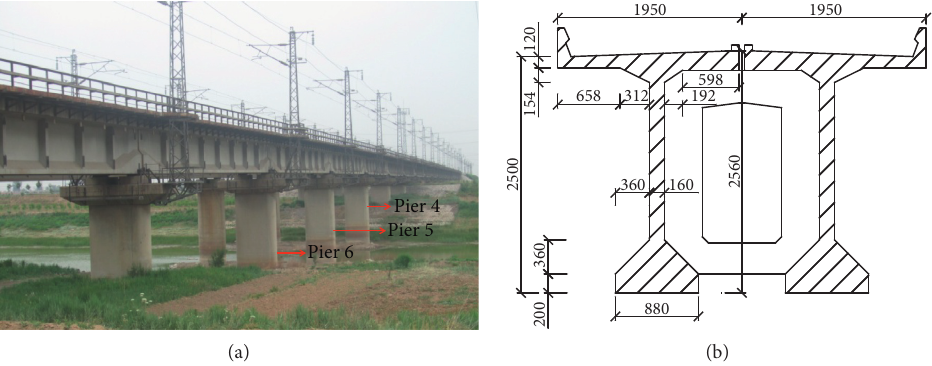
Figure 4: The 32 m prestressed concrete simply supported bridge. (a) View of the Nanpaihe Bridge. (b) Mid-span cross section (unit: mm).